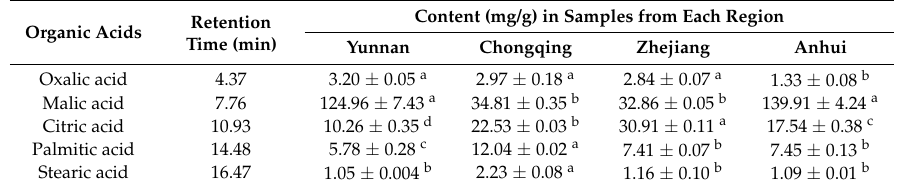
Table 3. Organic acid content of the dried fruits of C. speciosa from four production areas. Content (mg/g) in Samples from Each Region Organic Acids Retention Time (min)